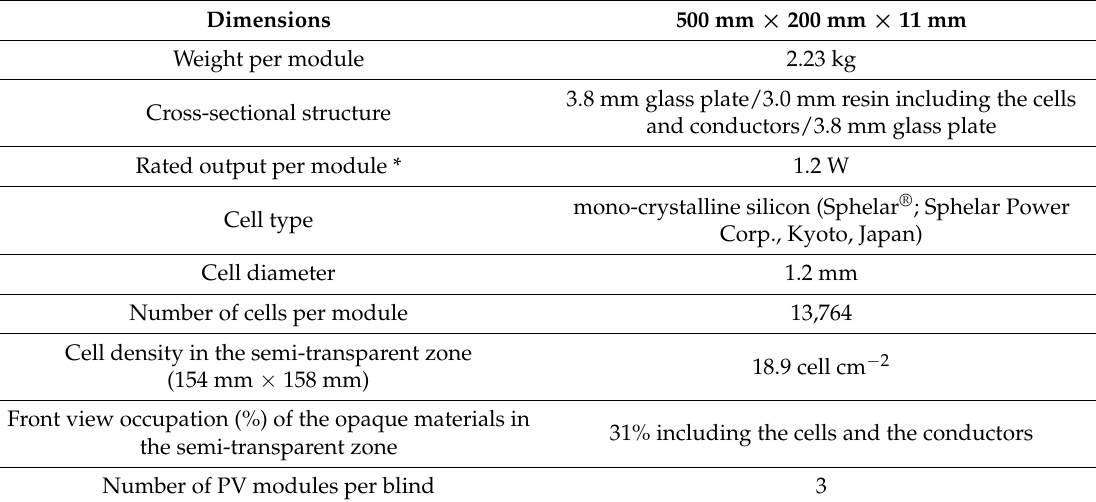
Front view occupation (%) of the opaque materials